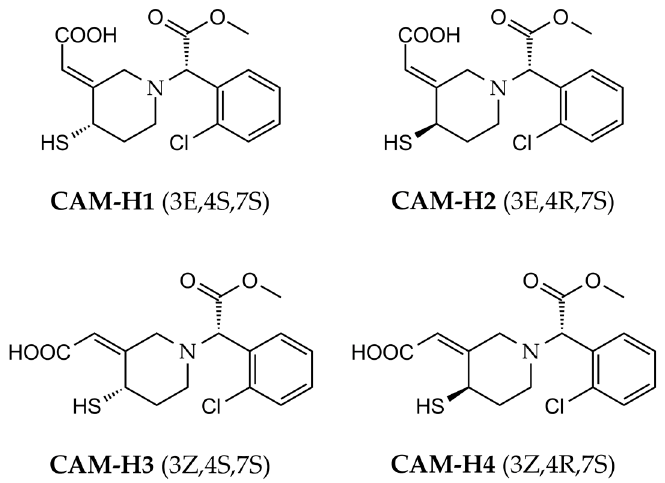
Figure 1. Structures of clopidogrel active metabolites H1–H4.